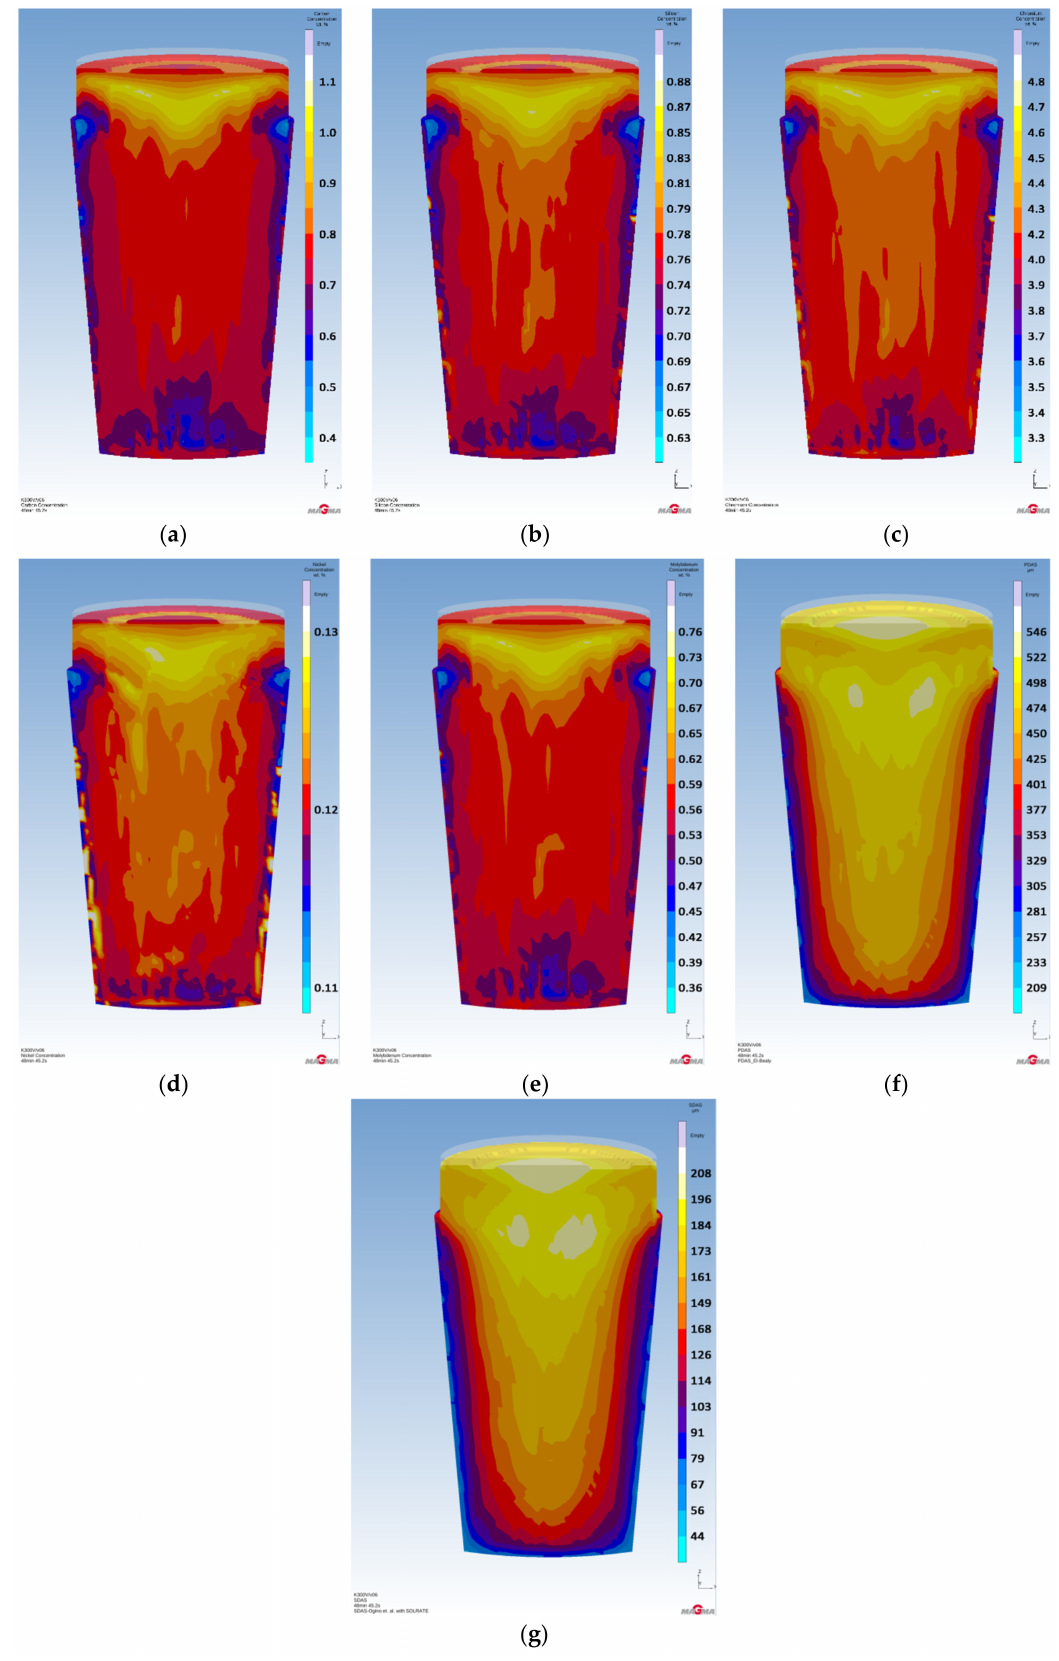
Figure 9. Element segregation, PDAS and SDAS: ( a ) [wt.% C]; ( b ) [wt.% Si]; ( c ) [wt.% Cr]; ( d ) [wt.% Ni]; ( e ) [wt.% Mo]; ( f ) PDAS; ( g )